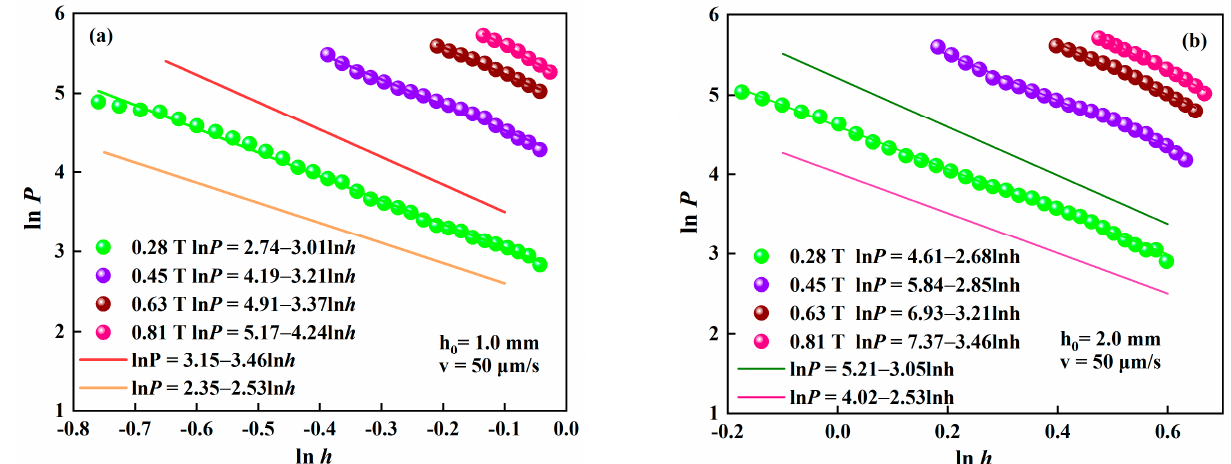
( b ) Figure 7. Logarithmic curves of compressive stress versus the instantaneous gap distance with